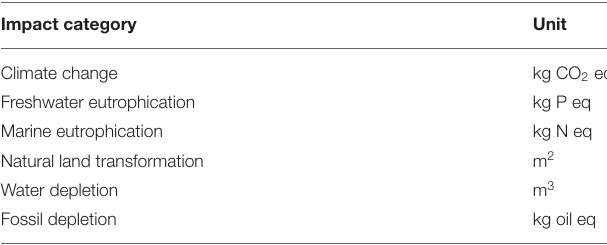
TABLE 2 | Impact categories considered in LCA